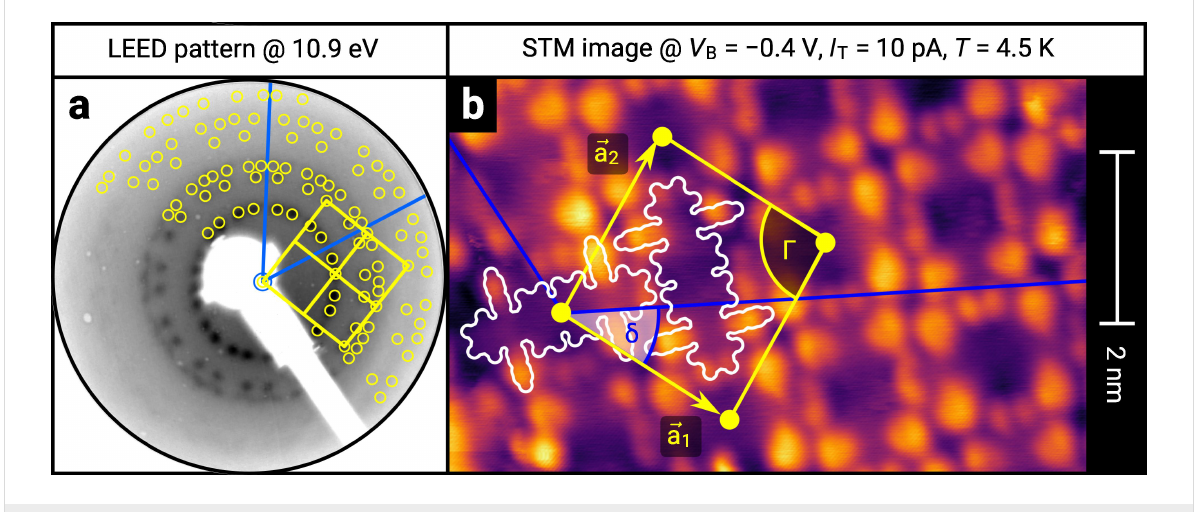
Figure 3: (a) LEED image (logarithmic intensity scale, contrast inverted) of the highly ordered DBP layer on h-BN/Ni(111) grown at a substrate tem- perature of 170 °C. Half of the LEED image is superimposed by the LEED simulation. Yellow points and lines correspond to the reciprocal lattice of the DBP structure including symmetry equivalents (rotational and mirror domains). Blue lines indicate two primitive reciprocal lattice directions of the substrate. (b) LT-STM image of the same sample, superimposed by the real-space structure of the molecular lattice (marked in yellow) as well as the contours of the two molecules in the unit cell. Blue lines indicate the direction of the primitive lattice vectors of the substrate. The lattice parameters are summarized in Table